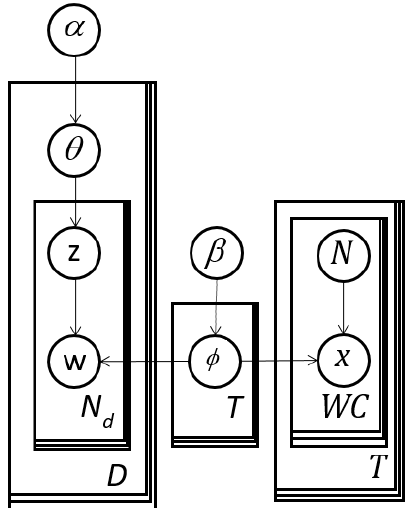
Figure 5. Expert Refined Topic (ERT) model with a handle permitting expert or user editing of the cluster or topic definitions. This figure is equivalent to the distribution in Equation (9).